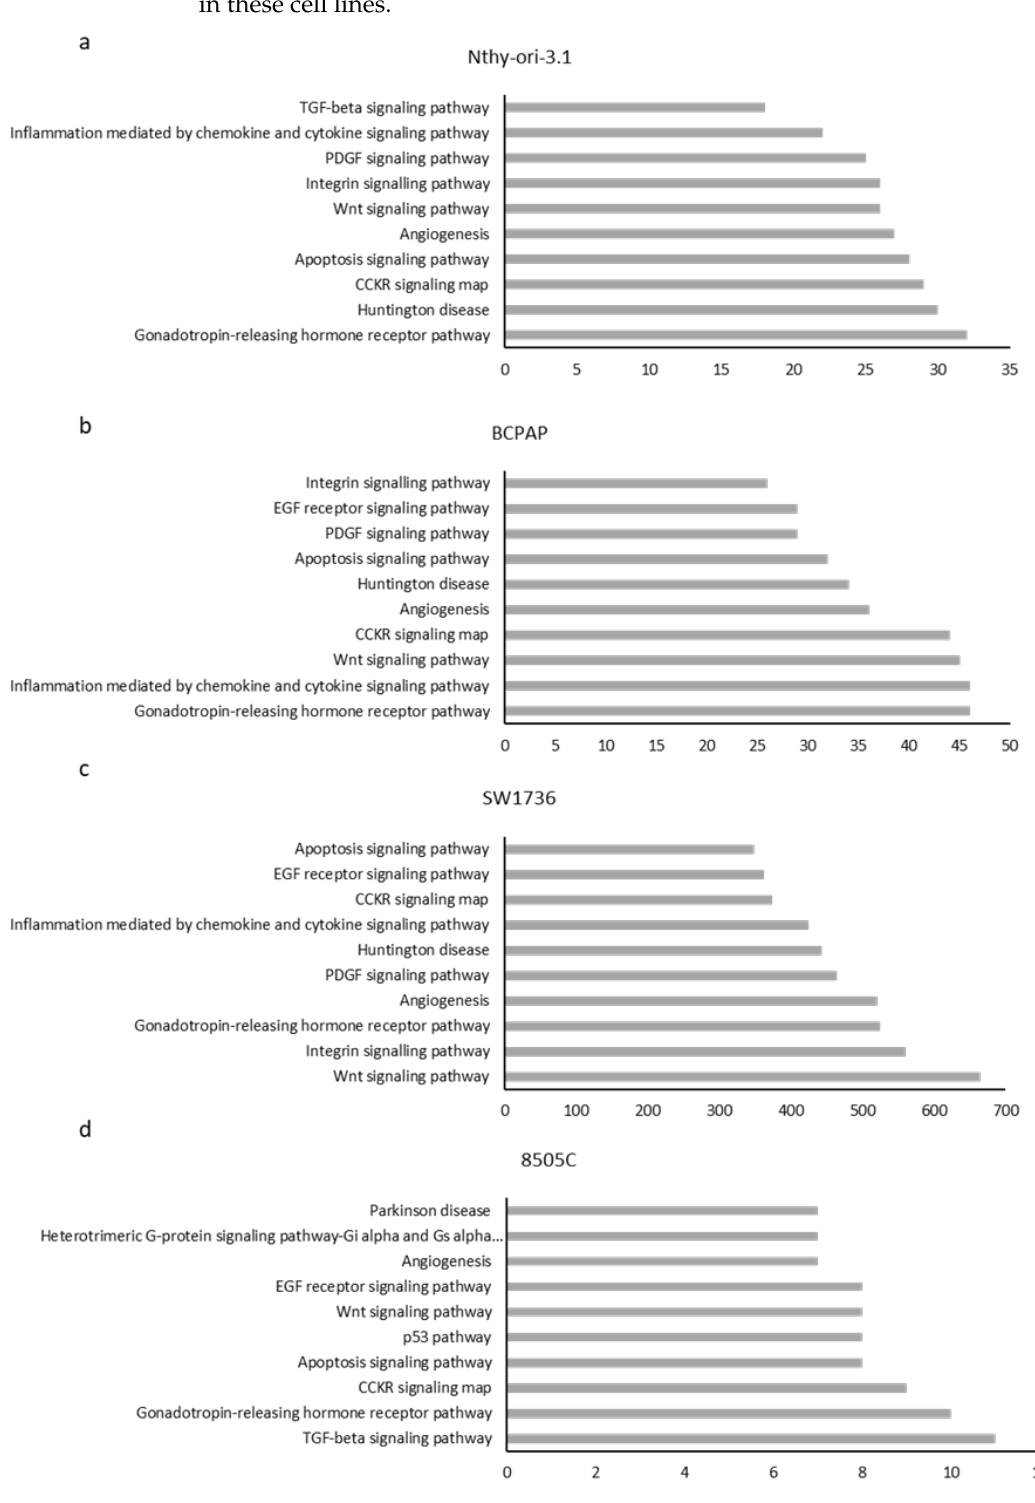
Figure 2. Histogram representing the top 10 pathways related to m6A enrichment in ( a ) Nthy-ori-3.1, ( b ) BCPAP, ( c ) SW1736, and ( d ) 8505C cell lines. The x-axis shows the number of genes involved in each pathway.